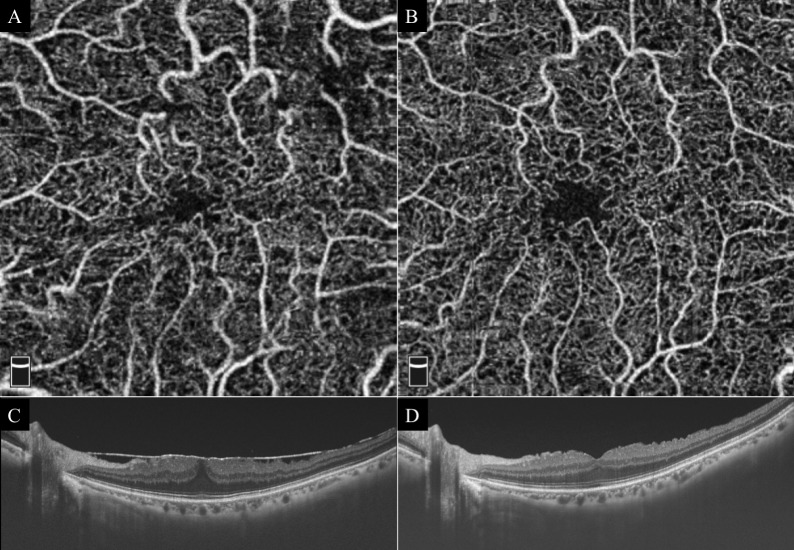
Representative case with an epiretinal membrane (EM).The foveal avascular zone (FAZ) increased and the central foveal thickness (CFT) decreased after vitrectomy with peeling of the internal limiting membrane (ILM). A: Superficial optical coherence tomography angiography (OCTA) image before vitrectomy. Area of FAZ is 0.072 mm2. B: Superficial OCTA image after vitrectomy. Area of FAZ is 0.148 mm2. C: Cross-sectional OCT image before vitrectomy. The central foveal thickness (CFT) is 405 μm. D: Cross-sectional OCT image after vitrectomy. The CFT is 270 μm.